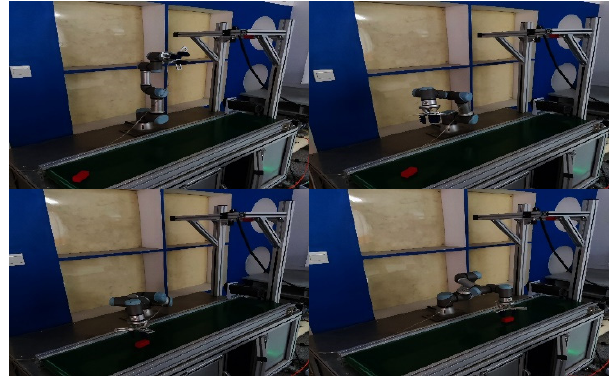
Figure 15. Experiments in low-resolution environment.